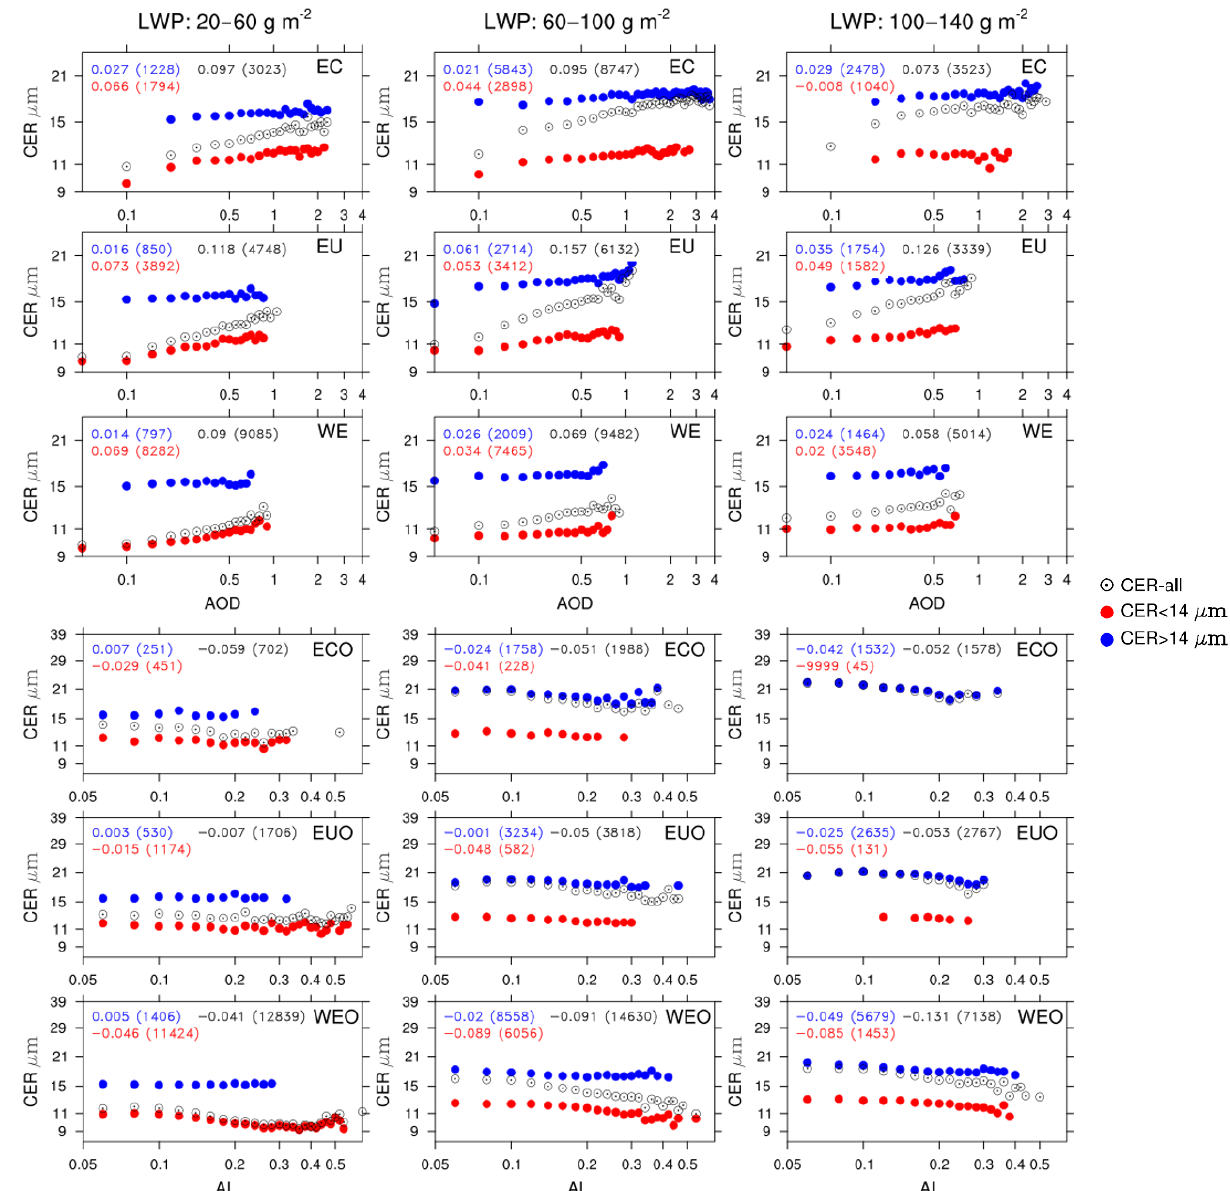
Figure 7. Cloud effective radius (CER) varies with aerosol loading (AOD for land, AI for ocean) under three liquid water path (LWP) categories (20–60, 60–100, 100–140gm − 2 ). The figures from top to bottom represent different regions (EC, EU, WE, ECO, EUO, and WEO). The blue (red) dots show the mean CER at each category of AOD (AI) in the case of CER > 14µm ( < 14µm), and the black circles indicate the results that do not differentiate CER. The slopes on a log–log scale along with the total number of samples (bracketed) for these three categories are also provided in each